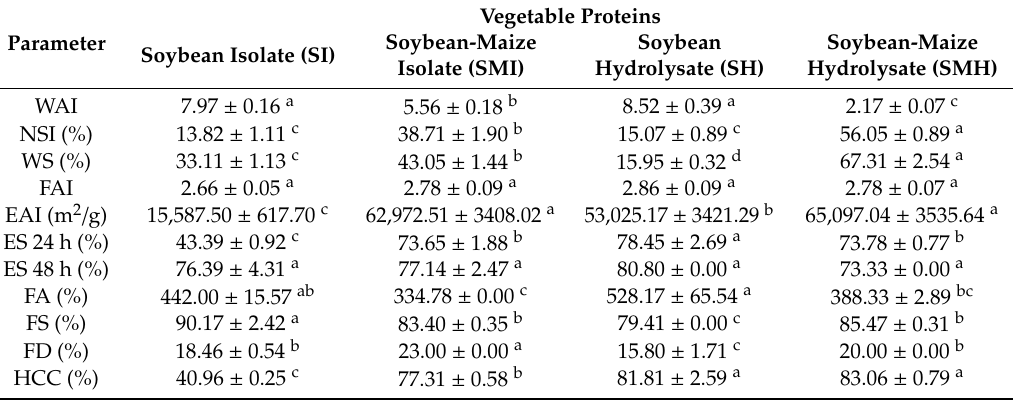
Table 2. Functional properties of isolates and hydrolysates of soybean-maize and soybean proteins 1 . Parameter Soybean Isolate (SI)